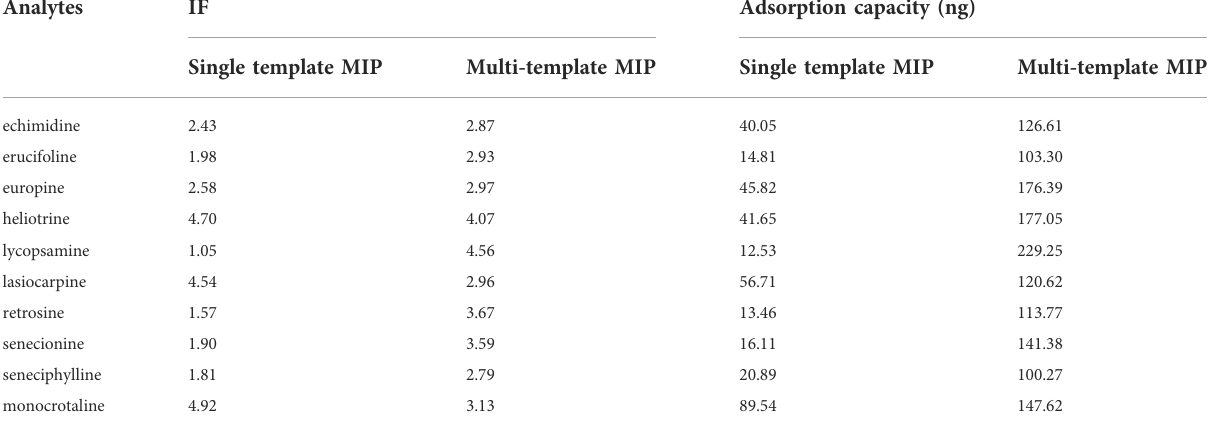
TABLE 3 Comparison of IF and adsorption capacity between single template MIP fi bers and multi-template MIP fi bers.